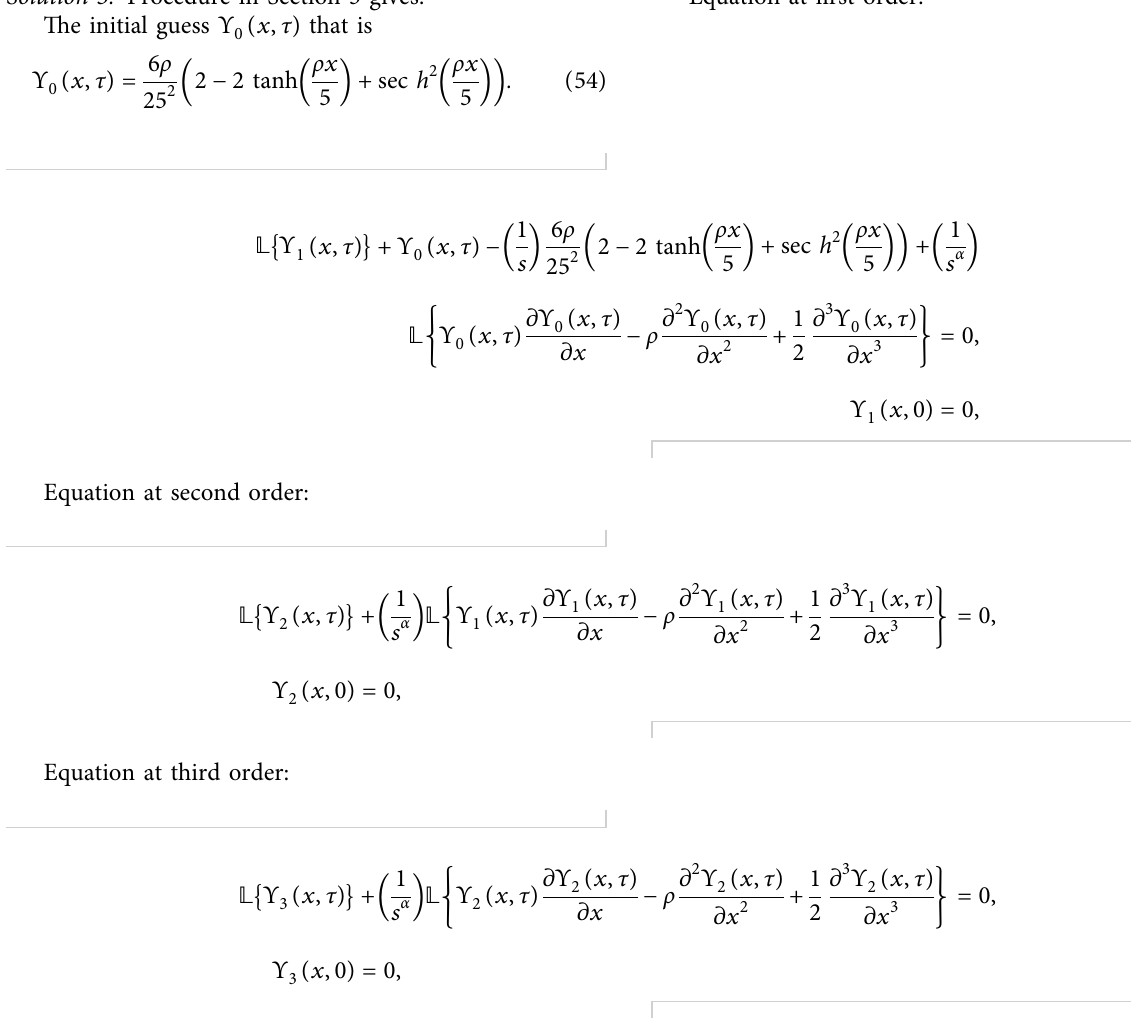
from Table 1. Solutions at third, sixth, and ninth itera- tions are compared. Increasing iterations by using the He-Laplace algorithm decrease in errors is observed. Table 2 expressed the residual errors calculated by